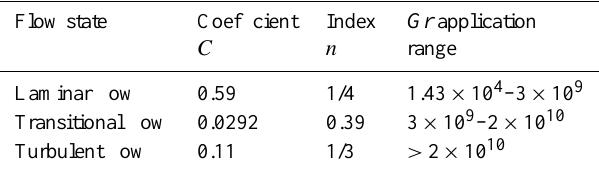
Table 1. Relative material parameters. Material Thermal Density